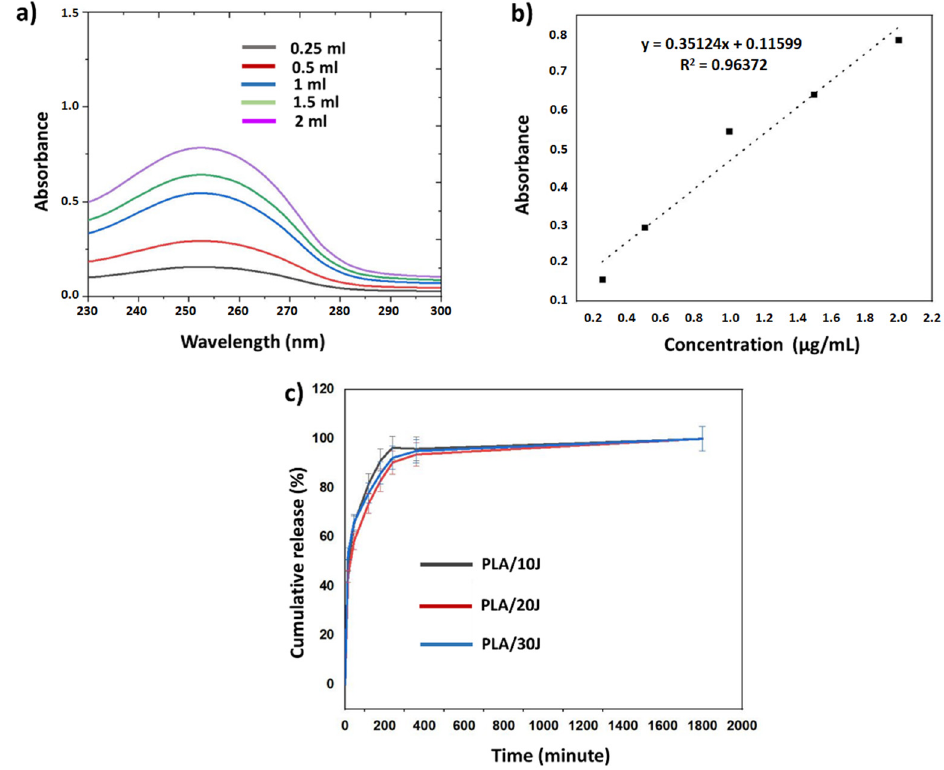
Figure 5. UV spectra of the juglone solution at different concentrations ( a ); calibration curve derived from the spectra ( b ); the cumulative release graph of the three scaffolds ( c ).